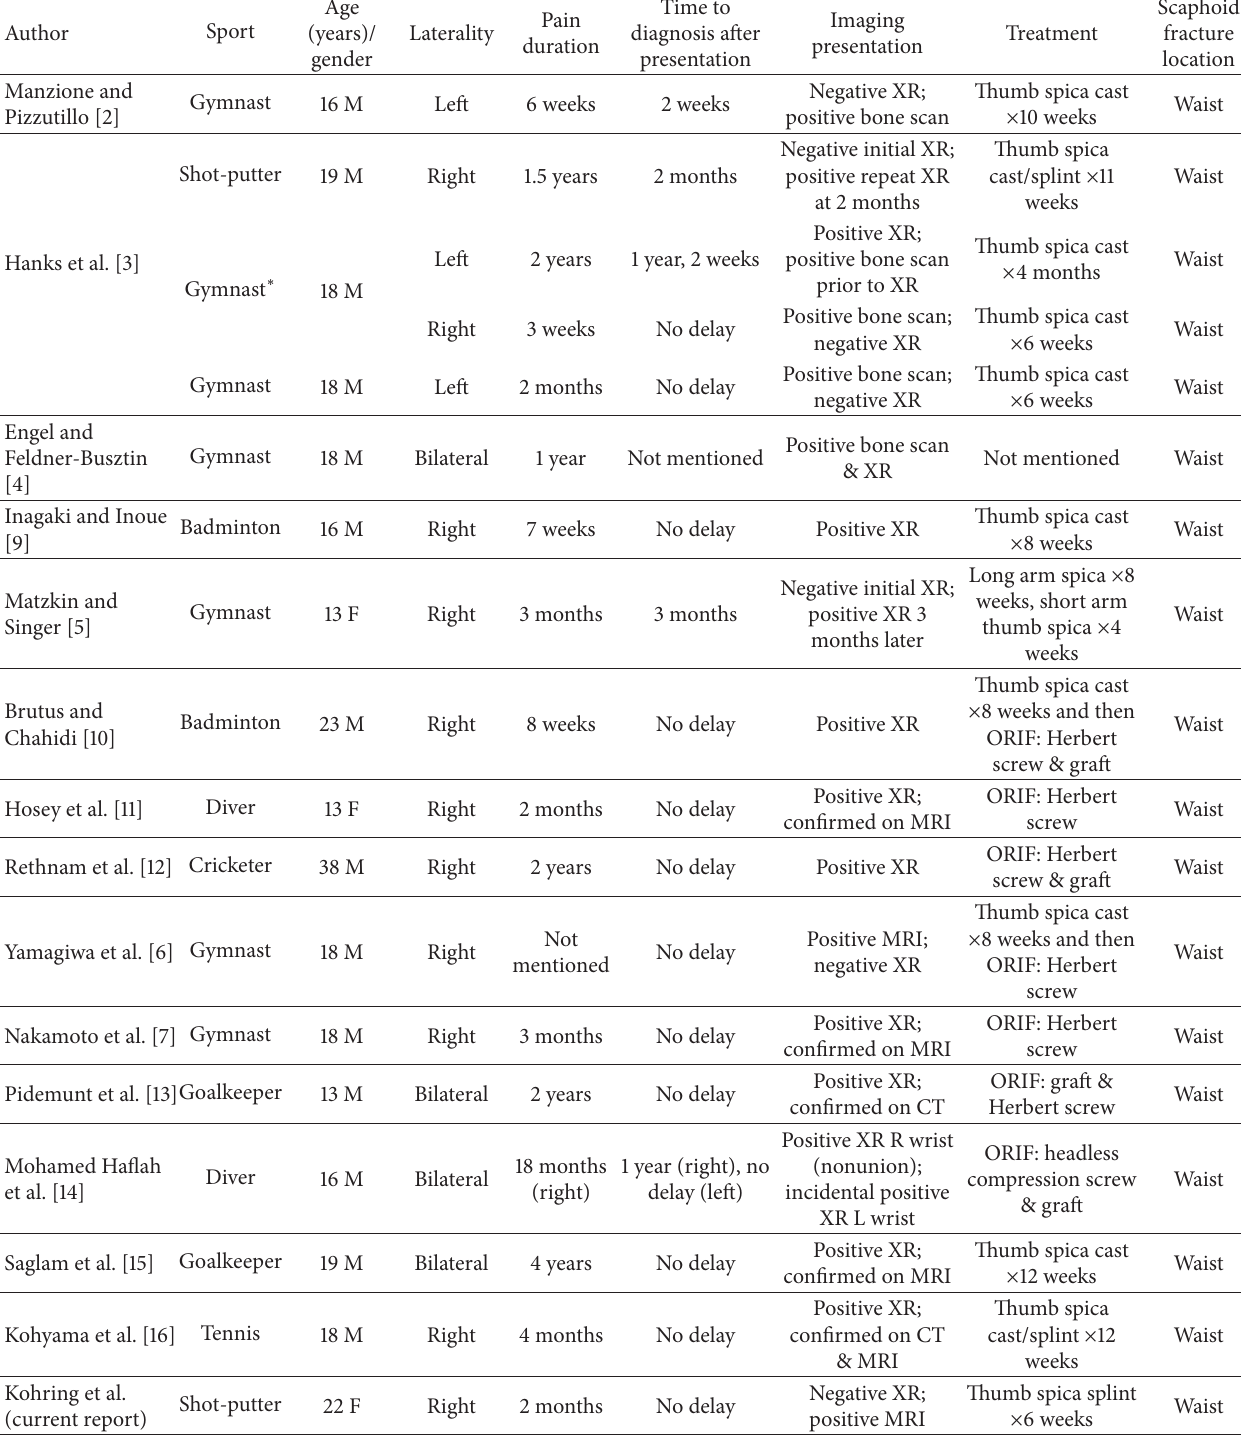
Table 1: Clinical characteristics, imaging evaluation, and treatment method for scaphoid stress fractures published in the literature.